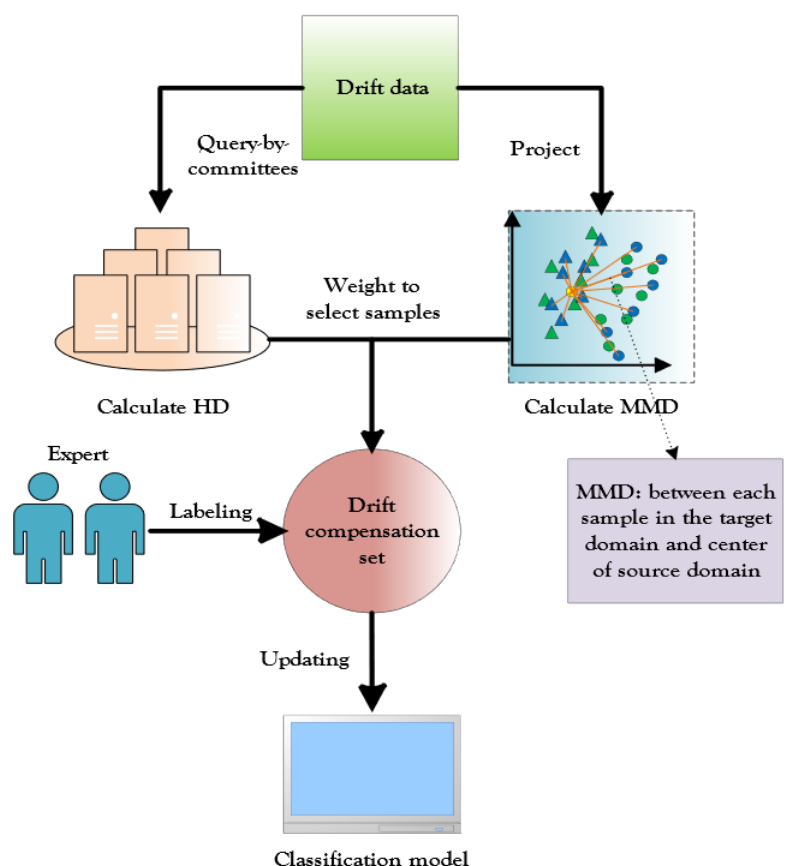
Figure 1. Schematic diagram of the CDAL framework. The cross-domain active learning method using weighted HD and MMD selects samples to update the classification model, which enables more representative labeled samples.